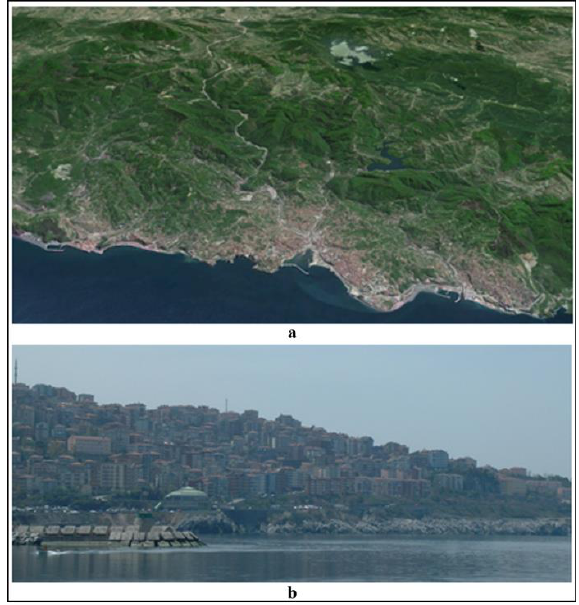
Figure 1. Zonguldak and its surrounding from Google Earth (a), and an example of Zonguldak topography